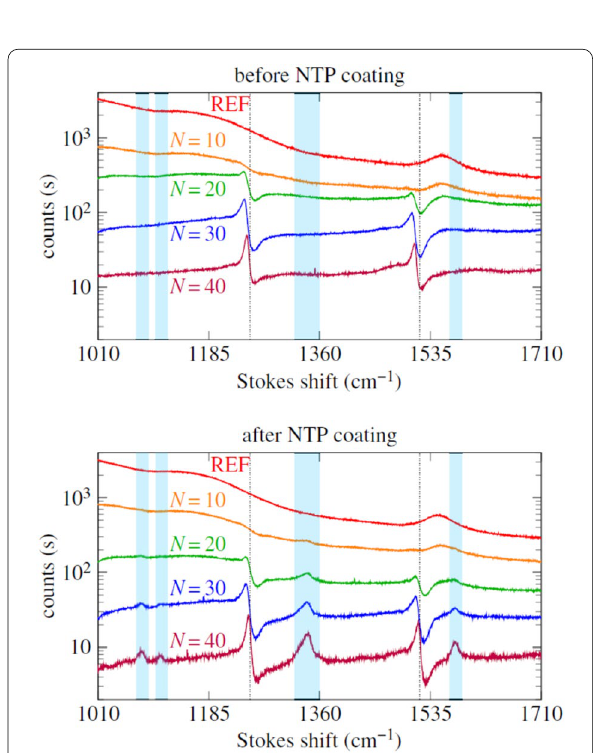
Fig. 11 Raman spectra, before and after NTP coating, of a reference waveguide (N 0) and waveguides functionalized with N = 40 antennas. (Reprinted with permission from Ref.